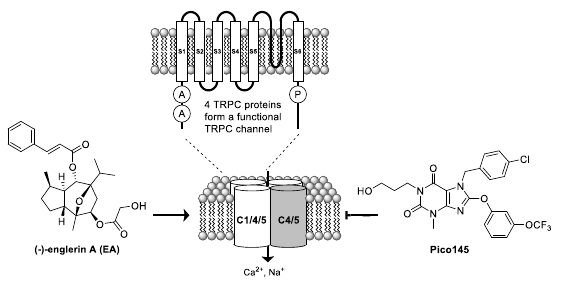
Figure 4. (-)-Englerin A (EA) and Pico145 are the most promising TRPC1/4/5 modulators. We hypothesize that EA and xanthines act via one or multiple distinct binding sites accessible from the extracellular side of the plasma membrane [19]. We will present the use of an integrated approach to understanding the mode-of-action of EA, xanthines, and en- dogenous modulators on TRPC1/4/5 channels. This includes the use of structure–activity